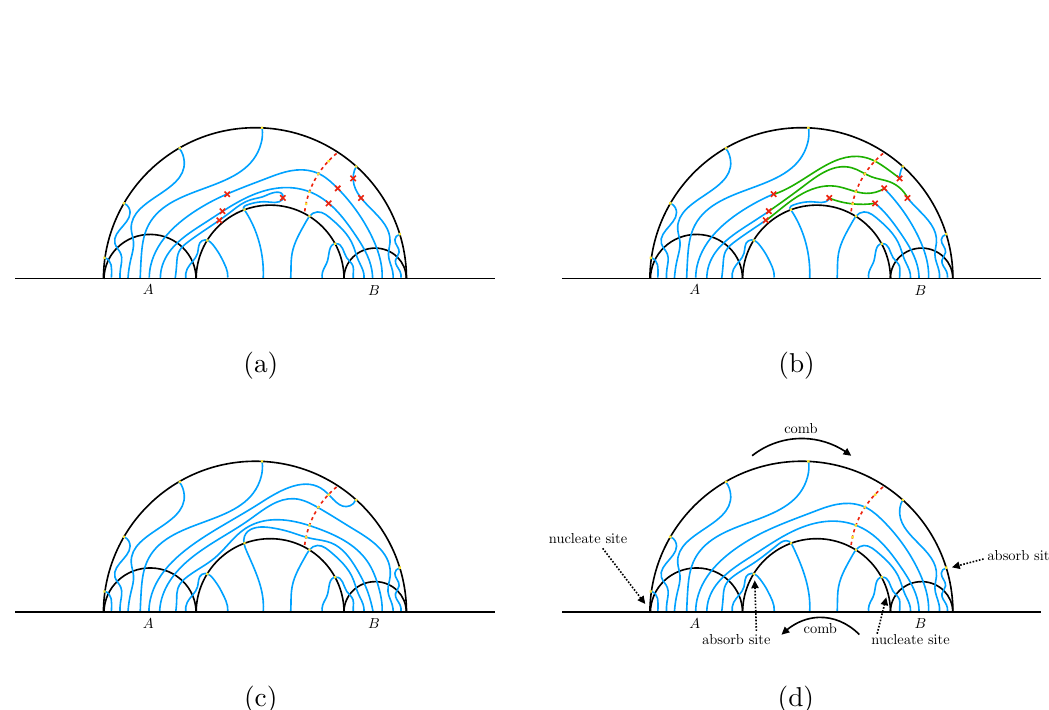
Figure 4 . Starting with a thread con(cid:12)guration that saturates the number of threads intersecting (cid:13) AB , (cid:13) A , and (cid:13) B , as shown in (a) and described in ref. [14], the goal is to construct a con(cid:12)guration like (c), which also saturates (cid:0). (The parts of threads that cross the exterior component of (cid:13) AB and that lie outside the entanglement wedge have been suppressed in these diagrams.) Diagram (b) illustrates how this can be done by cutting and gluing threads. First, with a UV cuto(cid:11) in